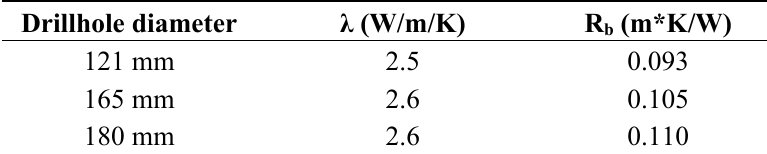
Table 1. Results obtained from the performed three TRT tests.